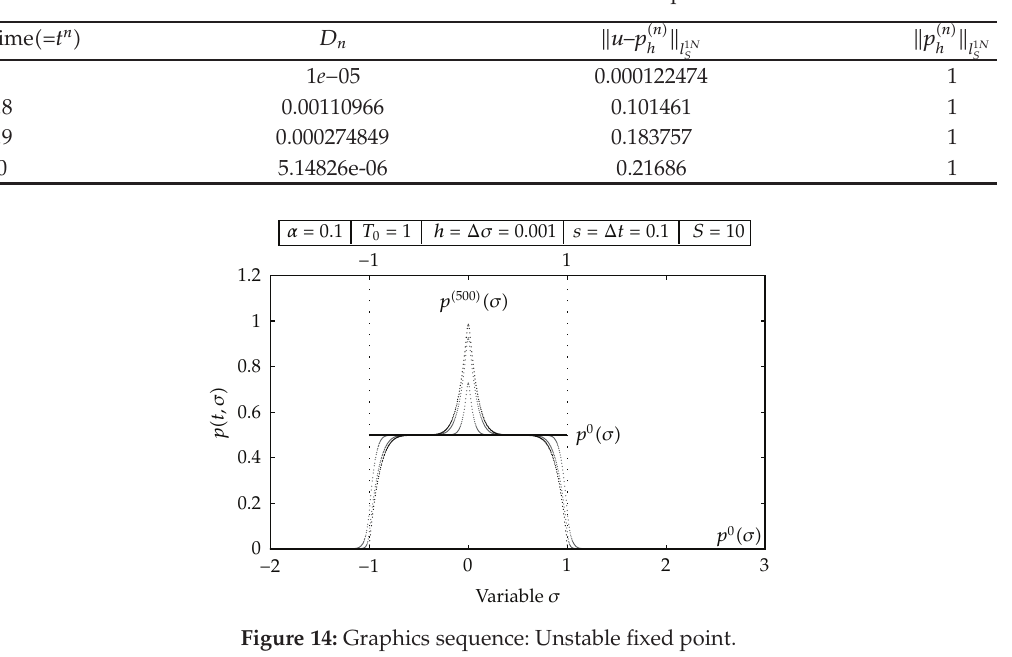
Table 12: Numerical results: Unstable fixed point.